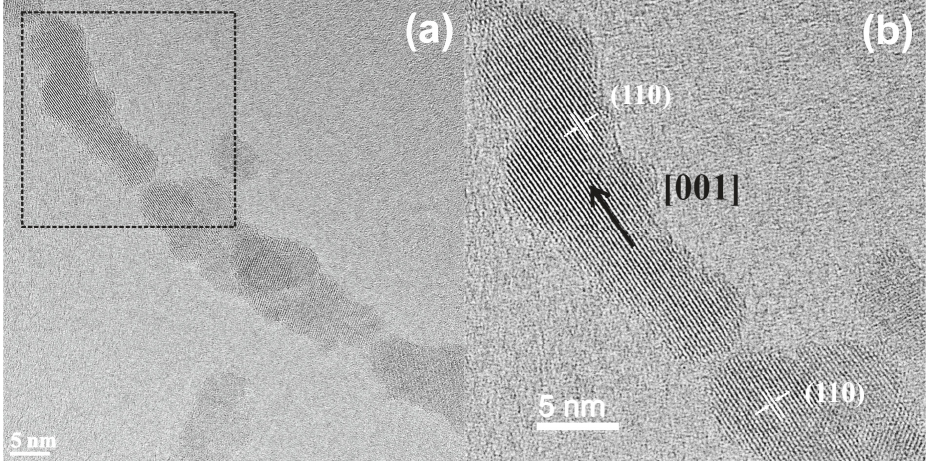
Figure 4. High-resolution TEM images of the hematite nanoparticle sample with 2.5 mM NaCl. ( a ) Image of a chain of hematite particles with lattice planes of neighboring particles aligned; ( b ) Enlarged view of the selected area in (a). The spacing between the lattice fringes corresponds to the (110) d-spacing.